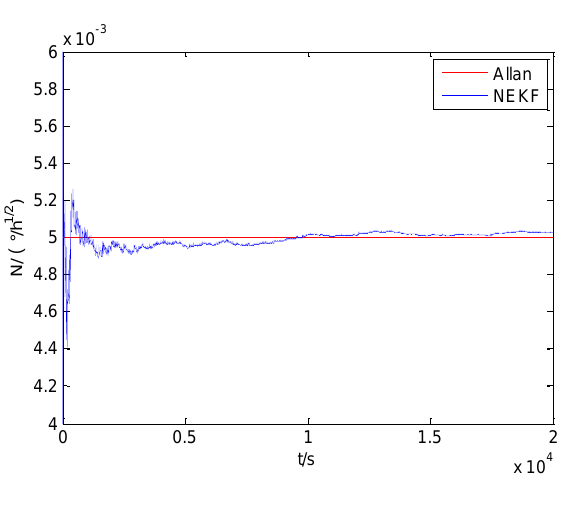
Figure 24. Estimation of N for #1 FOG.